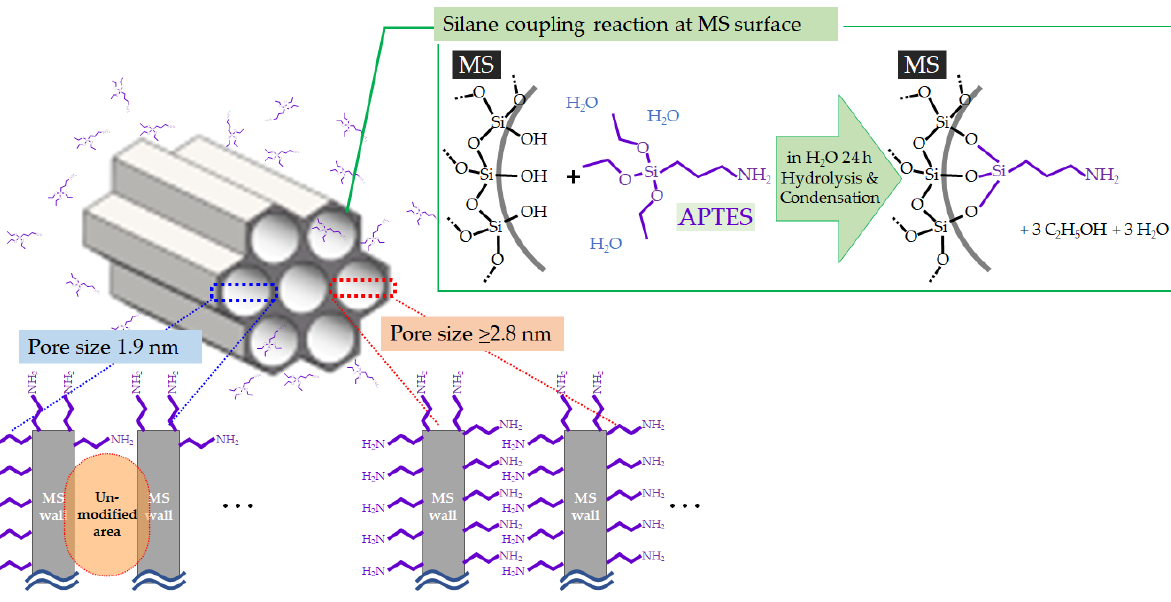
Figure 4. Expected reaction of APTES at the surface of MS and the anticipated effect of the difference in initial MS pore